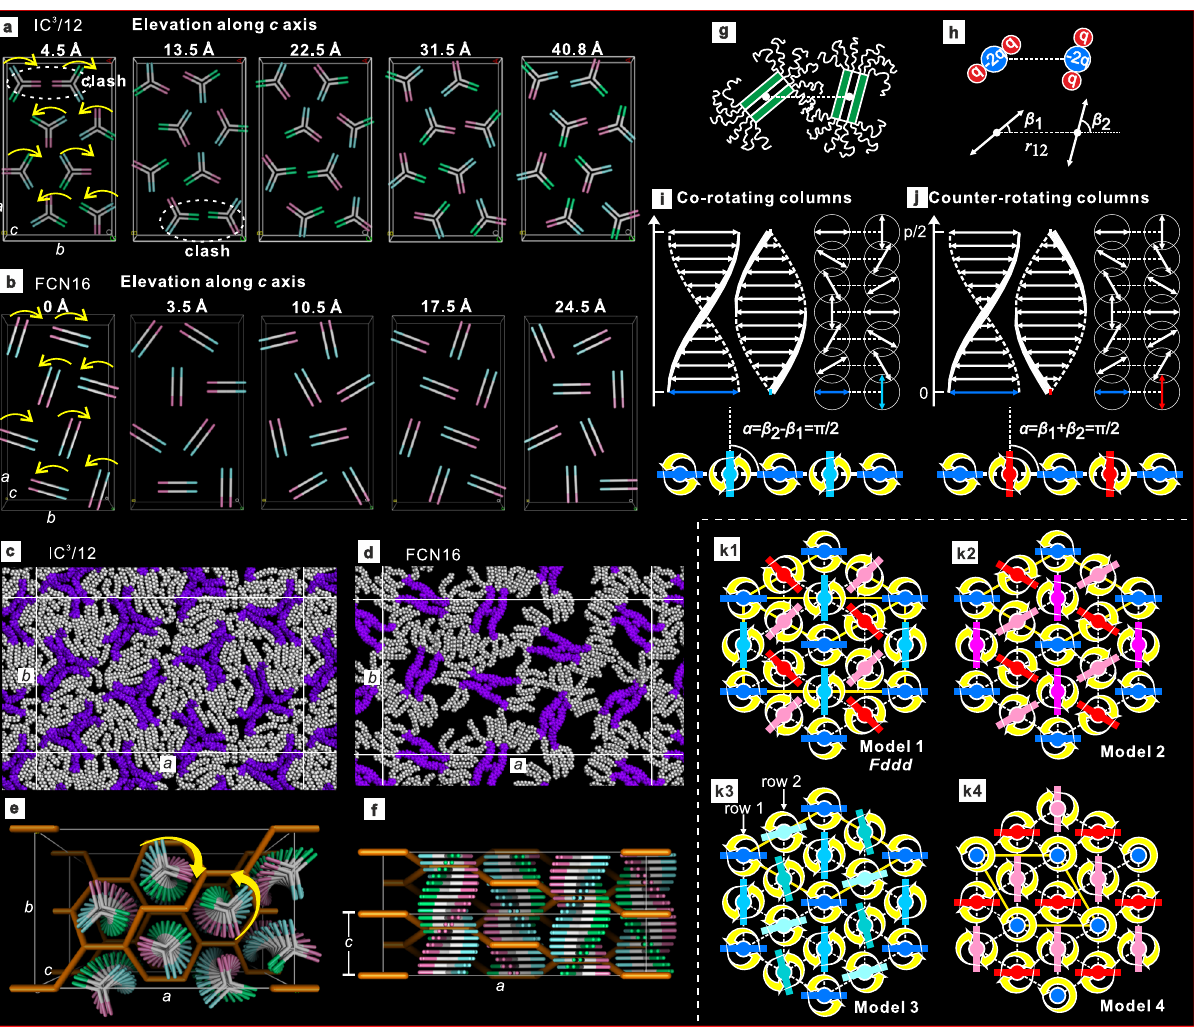
Fig. 6 Models of Fddd phase and its alternatives. a , b Layers at different z -elevation for ( a ) IC 3 /n and ( b ) FCN16/FO16. c , d Snapshots of MD-annealed atomistic models ( xy layer; purple: aromatic, gray/white: aliphatic). e , f Comparison of the network model of Fddd phase in poly(styrene- b -isoprene) (yellow rods) with the model of IC 3 /n. Arrows indicate a helical sense of both columns and network. g , h Two dimers of FO16/FCN16 on neighboring columns in g represented by quadrupoles in h , where geometrical parameters are also de fi ned. i , j Side and top views of ( i ) co-rotating and ( j ) counter- rotating ribbons. k Minimum-energy con fi gurations on a 2D-hexagonal lattice; k1 two left - and two right-handed columns in a 2 × 2 supercell, equivalent to the Fddd structure here observed experimentally; k2 three left- and one right-handed column in a 2 × 2 supercell; k3 four right-handed columns in a 2 × 2 supercell; it turns out that vertical shifting of the second row of columns relative to the fi rst does not change the system energy; ( k4 ) two left- and ffiffiffi p ffiffiffi p ´ one right-handed column in a 3 3 supercell. The orientation of right-handed columns can be random, which does not affect the system energy ( cf . structure in ref. 27 ). In k1 – k4 right- (left-)handed columns are shades of blue